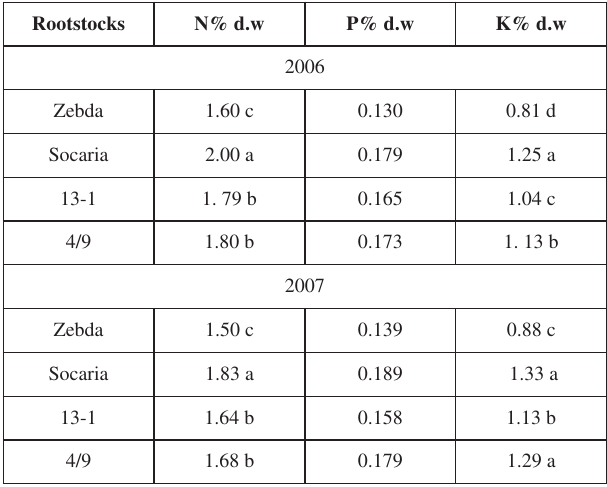
Table 3. Leaf nitrogen, phosphorous and potasium content (%) of Keit mango variety as affected by grafting on the four mango rootstocks in 2006 and 2007seasons.